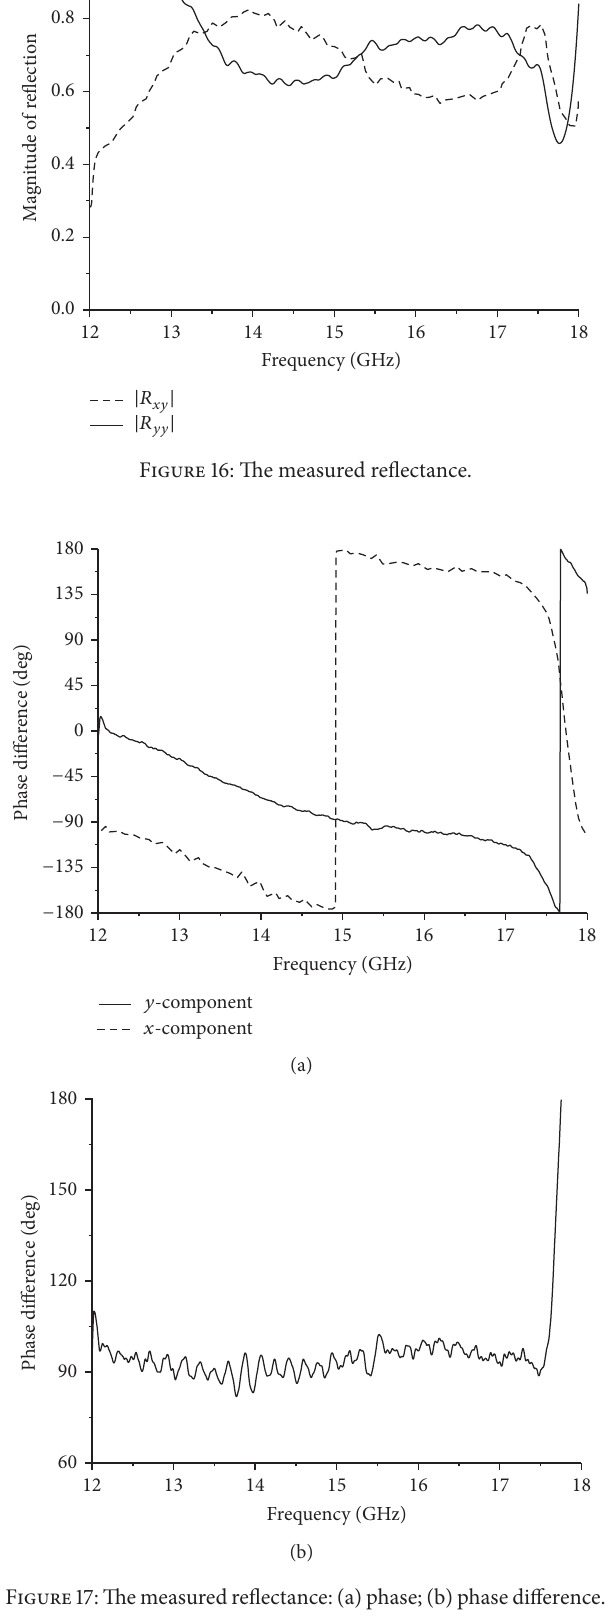
Figure 17: The measured reflectance: (a) phase; (b) phase difference.